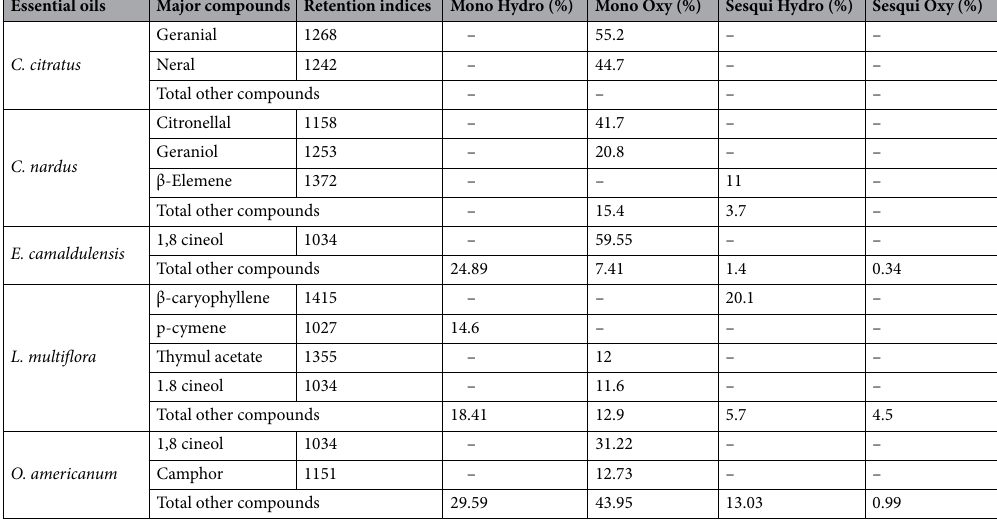
americanum consisted of twenty-six (26) compounds characterized by a high percentage of 1.8-cineole (31.22%) followed by camphor (12.73%). Knock-down times (KDT) and adulticidal effects of EOs and combinations. Lippia multiflora EO alone exhibited high toxicity with LC 50 values of 0.21 and 0.67%, LC 99 values of 0.74 and 1.17%, respectively (Table 3) and also with a rate of mortality of 100 and 96.88% at concentration (1%) on the susceptible Kisumu strain and the field strain VK, respectively (Table 4). This EO exhibited the lowest KDT 50 and KDT 95 values on both An. gambiae strains tested (19.8 and 87.2 min on Kisumu, 58.8 and 142.7 min on VK, respectively) (Table 4). E. camaldulensis EO was the least toxic with rate of mortality above 10% at concentration (1%) on the sus- ceptible Kisumu strain (Table 4), KDT 50 values of 144.8 min on the Kisumu strain, 166.1 min on the VK strain and LC 50 of 2.86 and 2.94%, LC 99 of 5.05 and 5.26% on Kisumu and VK strains, respectively. Moreover, EOs of C. nardus (LC 50 of 0.63 and 1.12% on Kisumu and VK, respectively) and O. americanum (LC 50 of 2.18 and 2.21% on Kisumu and VK, respectively) were more toxic than C. citratus (LC 50 of 2.3 and 2.7% on Kisumu and VK, respectively) (Table 3). For the susceptible strain Kisumu, no difference was observed between EOs of C. citratus , E. camaldulensis and O. americanum regarding the LC 50 and LC 99 . However, for the field strain VK, the confidence limits at 95% for the LC 50 and LC 99 do not overlap for all OEs tested (Table 3). Regarding the combinations on both An. gambiae strains (Kisumu and VK), the C9 combination exhibited high toxicity on all strains. Indeed, this combination shown a rate of mortality reaching 100% at concentration (1%) on both strains (Table 5). Conversely, with Permethrin, the rate of mortality reached 62.5% confirming the presence of phenotypic resistance on VK populations. In addition, C9 was the only combination that produced a synergistic effect on both strains (Tables 6 and 7). Also, this combination exhibited the lowest KDT values (Table 5) and the lowest LC 50 and LC 99 values on both strains (0.22 and 0.52% with Kisumu, 0.32 and 0.59% with VK) (Tables 5). Moreover, the combinations C6 and C8 exhibited high toxicity with rates of mortality above 98% at concentra- tion (1%) on the Kisumu strain while on VK strain, the toxicity of these two combinations was 45.21 and 80.7% at concentration (1%). With these two combinations, the KDT values were slightly low on both strains (on strain VK: KDT 95 = 20.7 min 12.2 min at the 1% concentration for C6 and C8, respectively) and, the LC 50 and LC 99 were low on both strains (LC lowest diagnostic concentrations of 1.04%, 1.16% and 1.48% were obtained with C9 and C8 and L. multiflora EO, respectively (Table 3). The LC 50 obtained with the C8 combinations on VK strain showed no difference with those obtained with C. nardus EO with no overlapping confidence intervals. As well, the LC 50 obtained with C3, C4, C5 and C7 showed no difference with those obtained with O. americanum EO on VK strain (Table 3). The resistance ratios obtained with all EOs as well as those of all combinations were below 5 (Table 3).